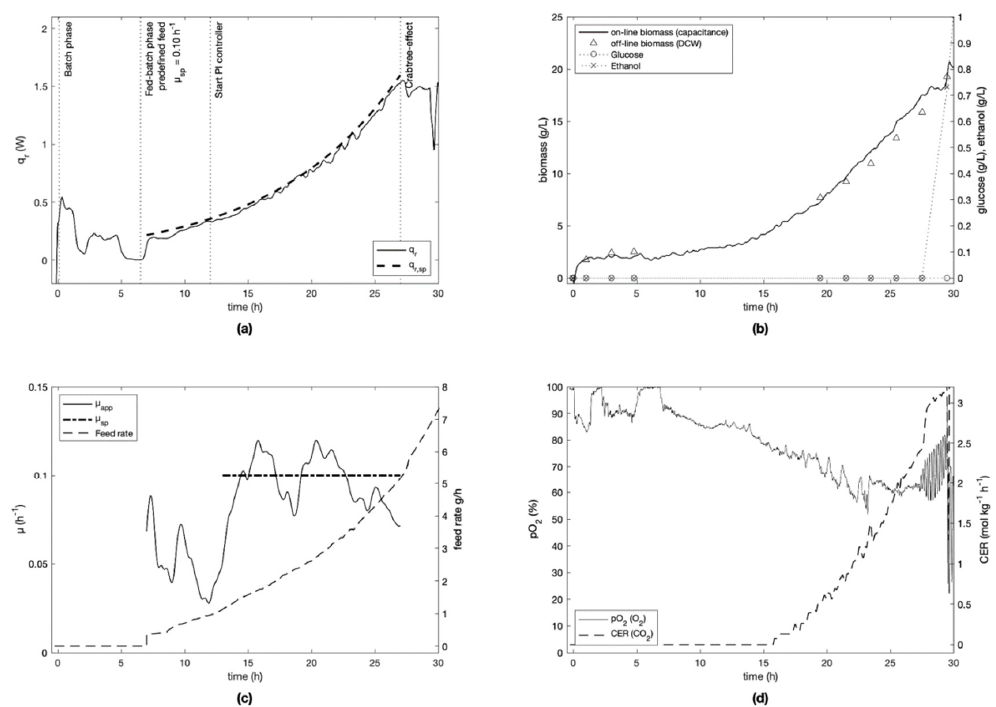
Figure 4. Fed-batch culture (E-2) of S. cerevisiae with µ sp of 0.10 h − 1 . ( a ) q r and q r,sp profiles. Events indicated by vertical lines. ( b ) Biomass profiles. Glucose and ethanol concentrations. ( c ) µ app from dielectric spectroscopy, µ sp and F feed . Controller MRE of 14% achieved. ( d ) pO 2 and CER. Oscillations of the pO 2 signal and the decrease in q r after 27 h are due to a switch form aerobic respiration to a fermentation transition metabolism after the controller was switched off.